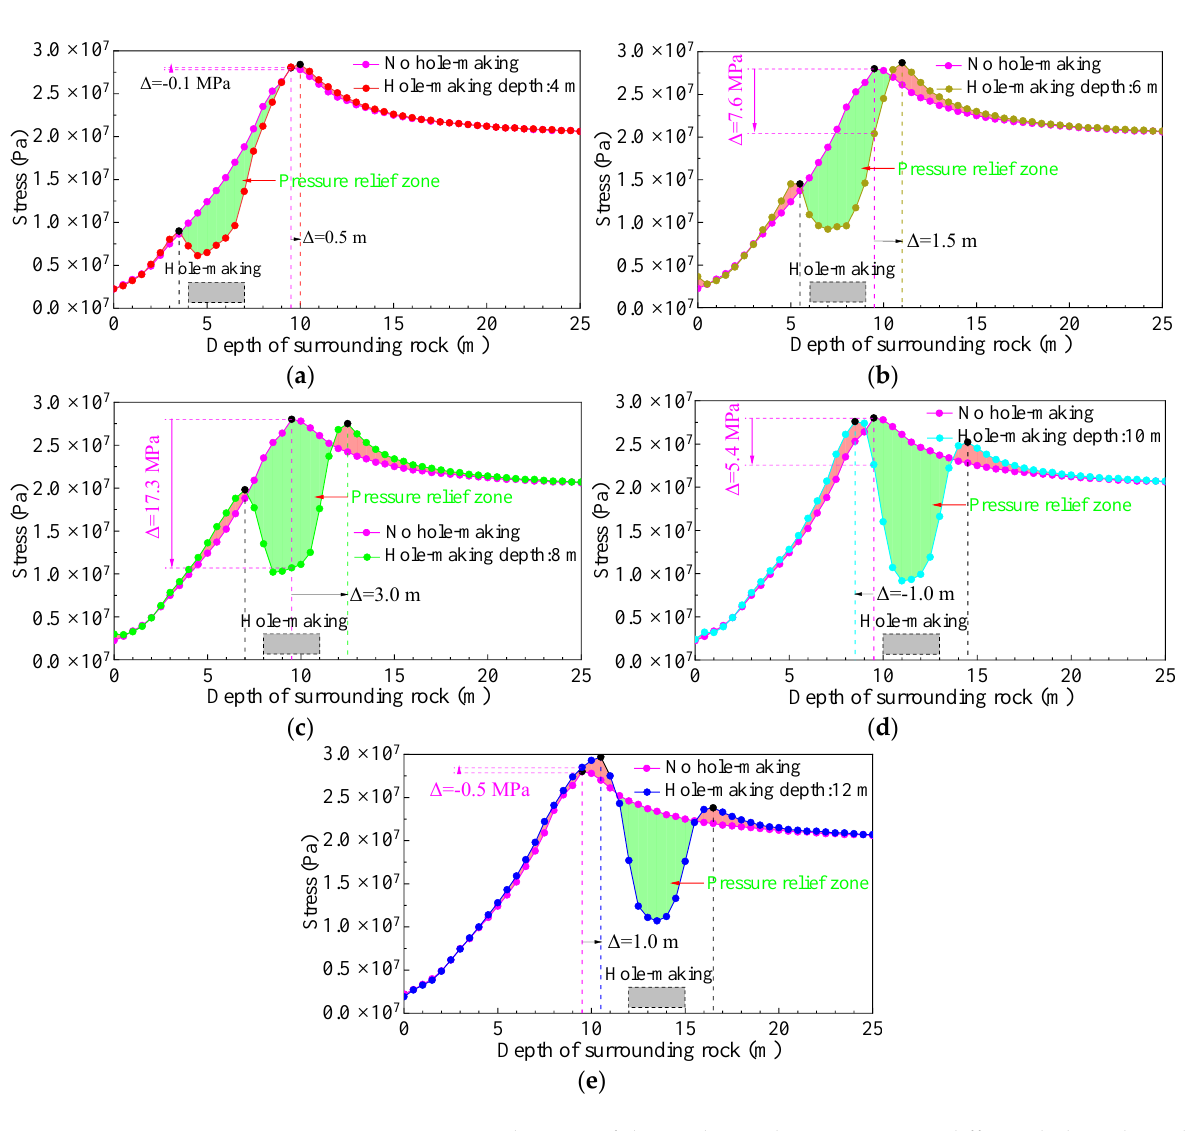
Figure 10. Comparison diagram of the roadway rib stress curve at different hole-making depths. ( a ) Hole − making depth = 4 m; ( b ) Hole − making depth = 6 m; ( c ) Hole − making depth = 8 m; ( d ) Hole − making depth = 10 m; ( e ) Hole − making depth = 12